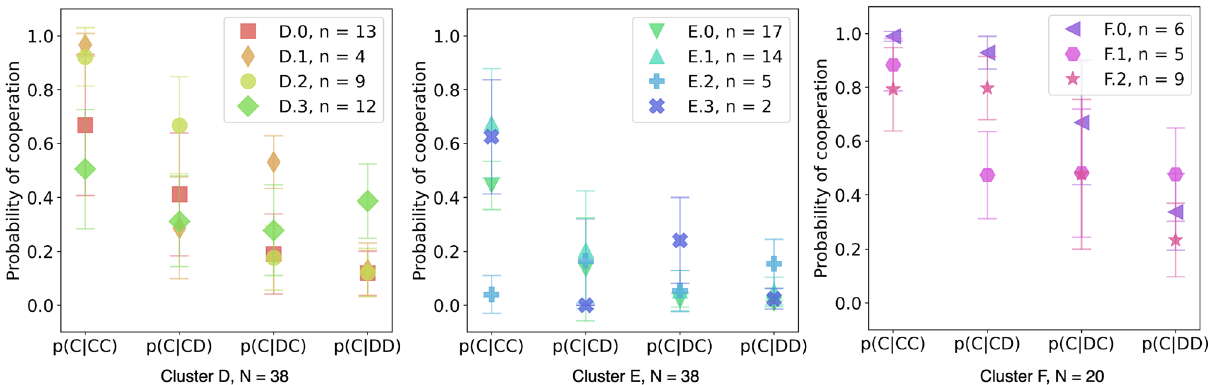
Figure 6. Probability of cooperation given each context for the Shuffled Partners treatment. In the x-axis, it is shown the probability of cooperating given that in the previous round there was a certain context. The bars represent the binomial error. Each cluster is divided into sub-cluster that were divided using the frequency of cooperation given a context.